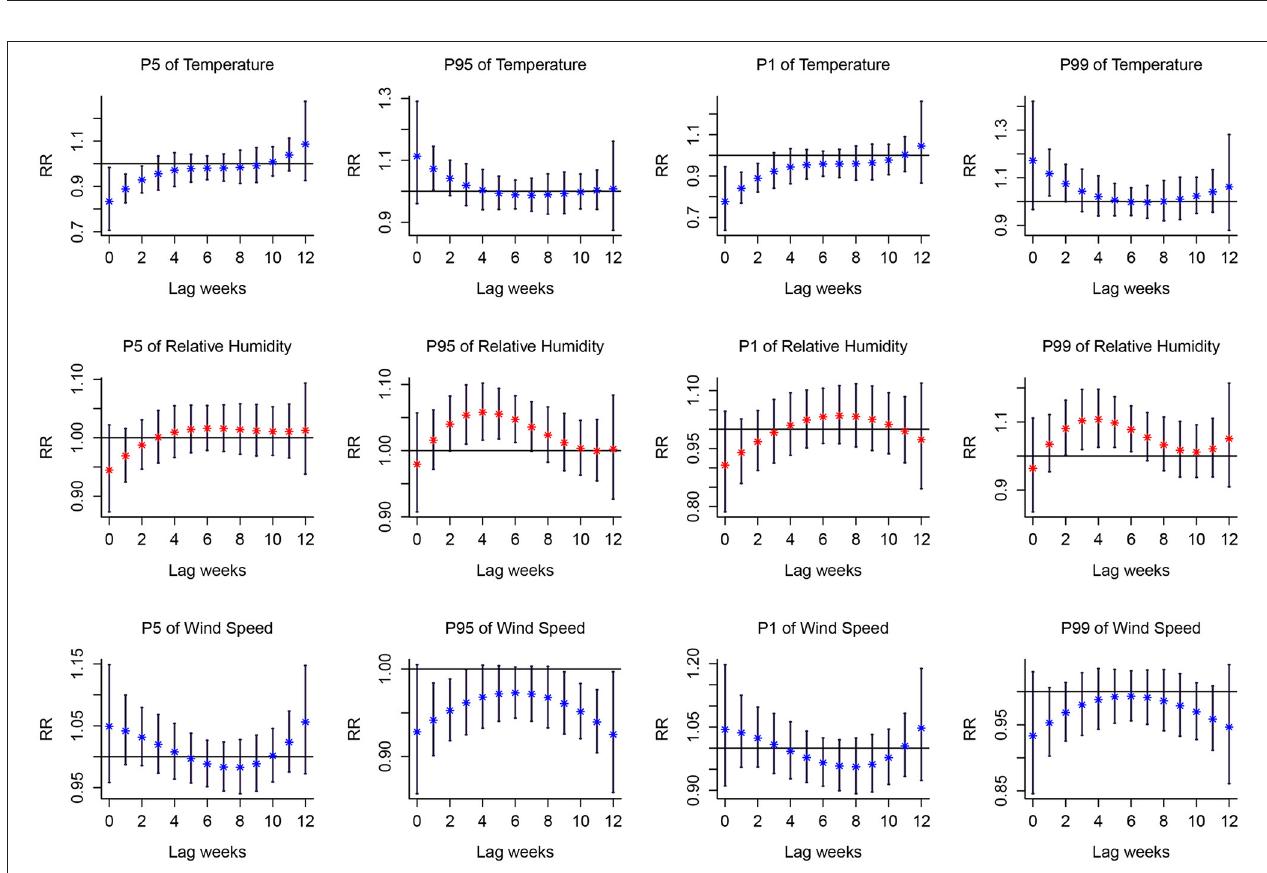
cumulative effects at the 99th percentile of relative humidity (RR = 1.905, 95%CI: 1.128–3.216). Compared with the median wind speed, the 95th percentile wind speed was associated with the increased cumulative risk of PTB (RR = 0.547, 95%CI: 0.432– 0.692). Extreme low relative humidity and extreme low wind speed did not have any cumulative effect on